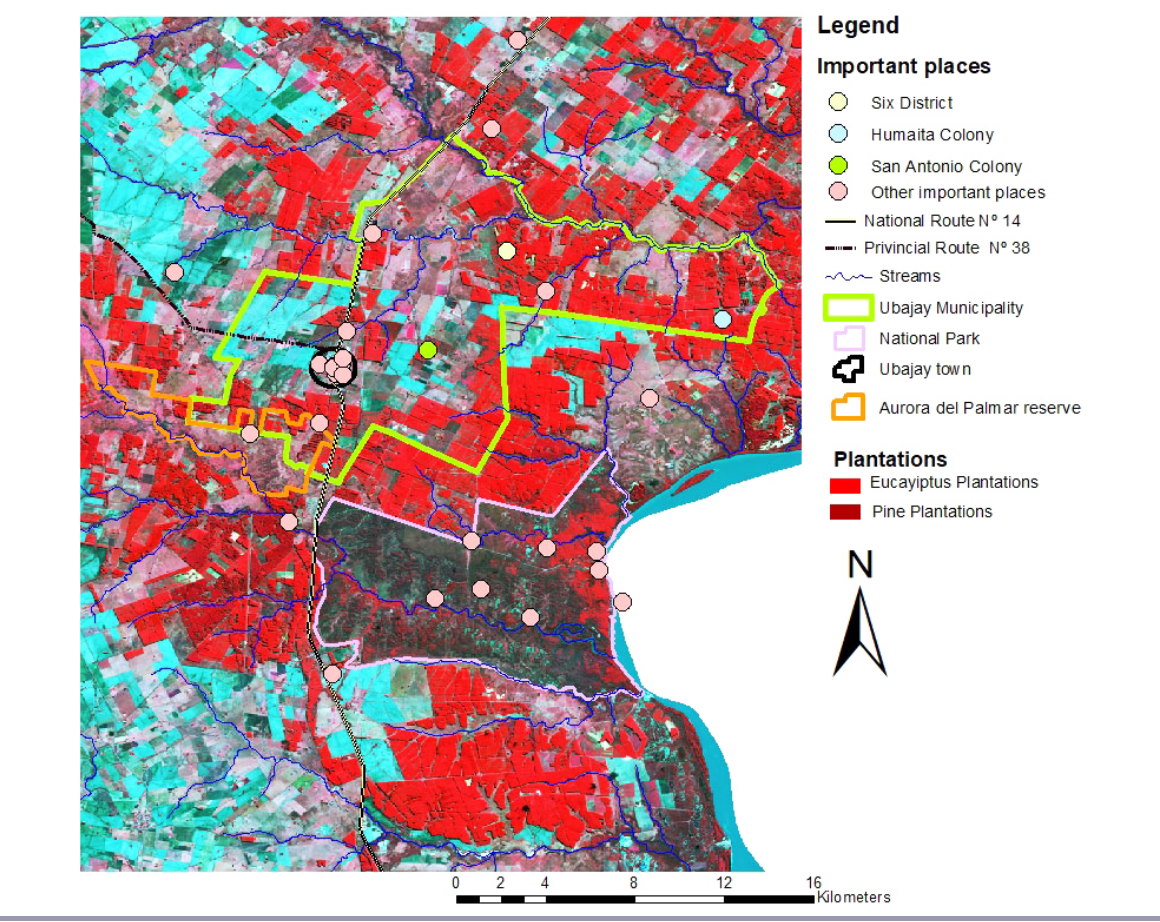
Fig. 3 . Monoculture plantations and special places in